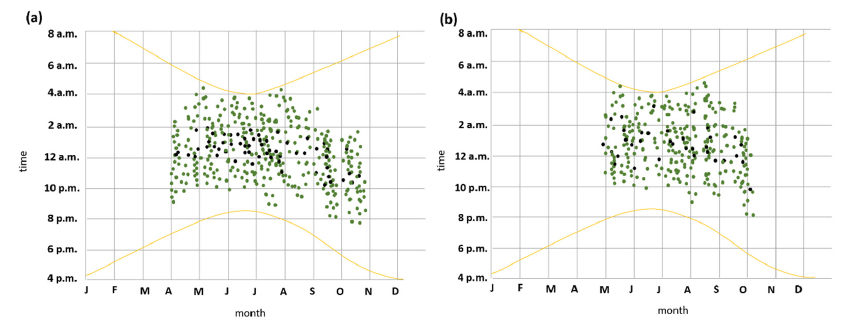
Figure 8. Annual and nocturnal distribution of activity of P. auritus ( a ) and P. austriacus ( b ). Green dots show time of recordings at two distinct maternity colonies in 2014; black dots show time of all mist-netting capture events of individuals between 2012 − 2014. The yellow curve lines mark sunset and sunrise (Central European Time, CET or Coordinated Universal Time, UTC + 1).